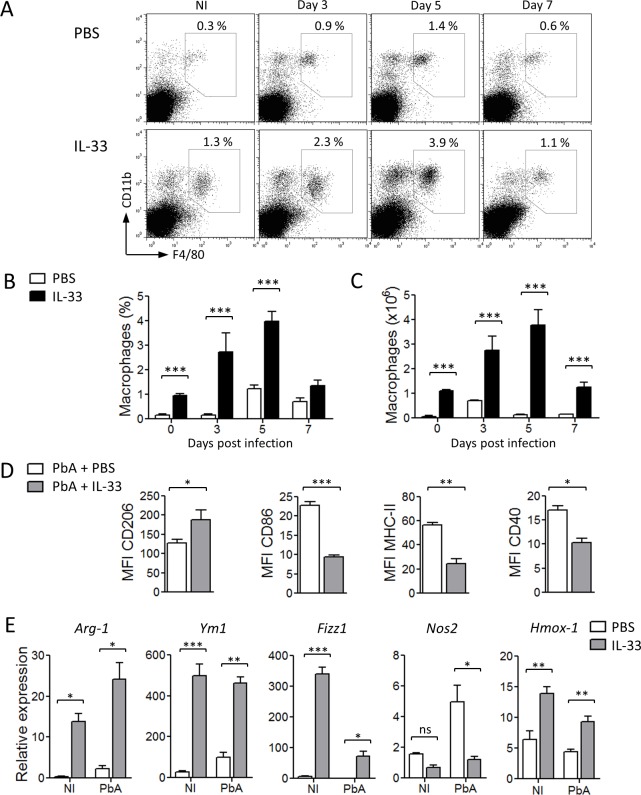
IL-33 polarizes M2 macrophages in PbA-infected mice.C57BL/6 mice were not infected (NI) or infected i.v. with PbA and treated daily for 5 days with PBS or IL-33 and spleen cells were harvested at indicated time points and analysed. (A) Representative dotplots showing percentage of CD11b+F4/80+ cells among total splenocytes. (B) Percentages and (C) numbers of CD11b+F4/80+CD11c− macrophages in the spleen. (D) Mean Fluorescence Intensity (MFI) of CD206, CD86, MHC-II and CD40 on macrophages (n = 5 per group). (E) Expression (relative to Hprt1) of Arg-1, Ym1, Fizz1, Nos2 and Hmox-1 mRNA in the spleen on day 5. Data are mean ± SEM, representative of 2 independent experiments. ns, not significant, *P<0.05, **P<0.01, ***P<0.001 by two-tailed ANOVA.